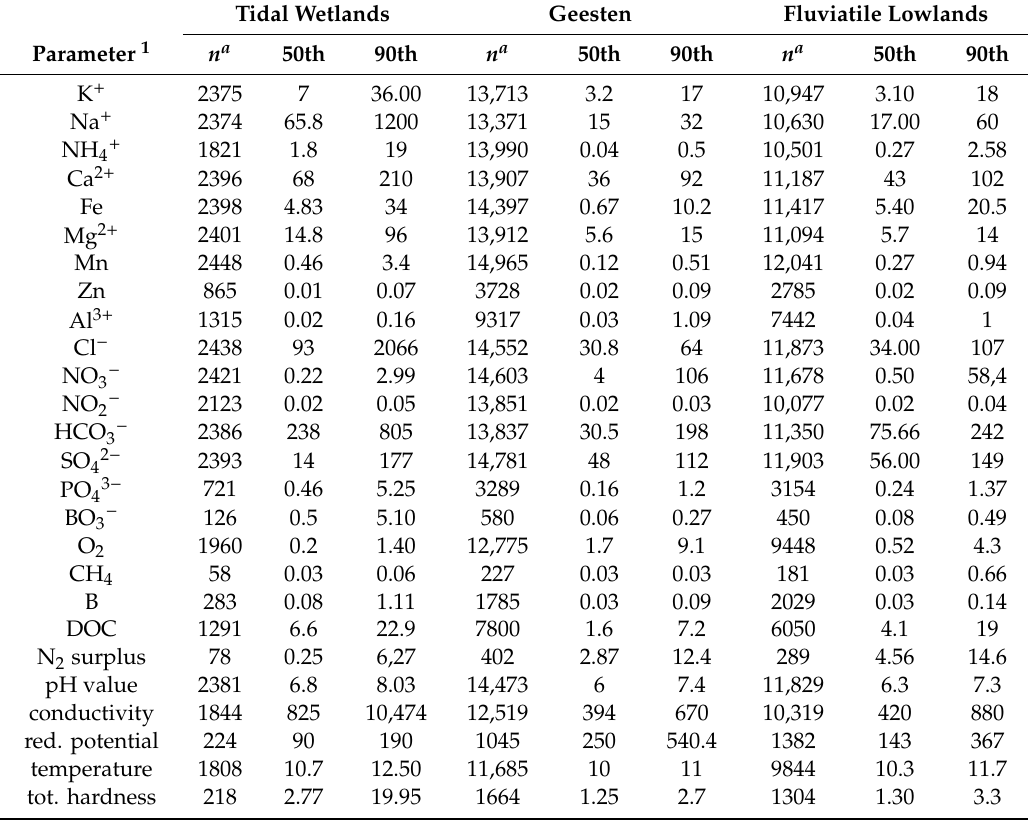
Total analysis number ( n a ), 50th and 90th percentile concentration within each hydrogeological unit. Tidal Wetlands Geesten Fluviatile